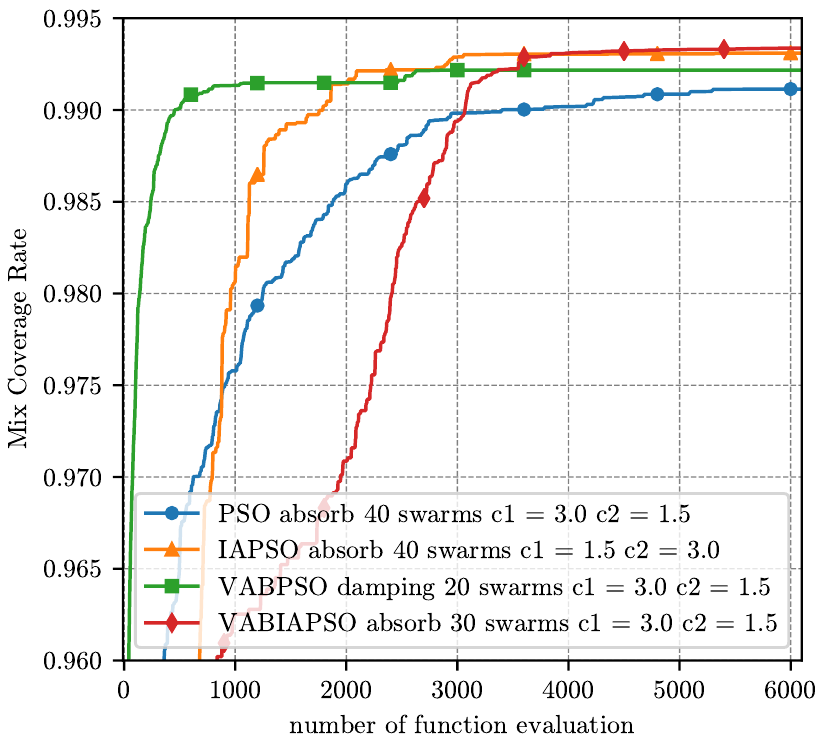
Figure 7. Performance comparison of four algorithms under the optimal parameters of the ideal scene. The final mix coverage of the four algorithms is close to 100%, which shows the speed is relatively slow compared with the standard PSO algorithm. When the IAPSO algorithm runs nearly 900 operations, the convergence speed exceeds the standard